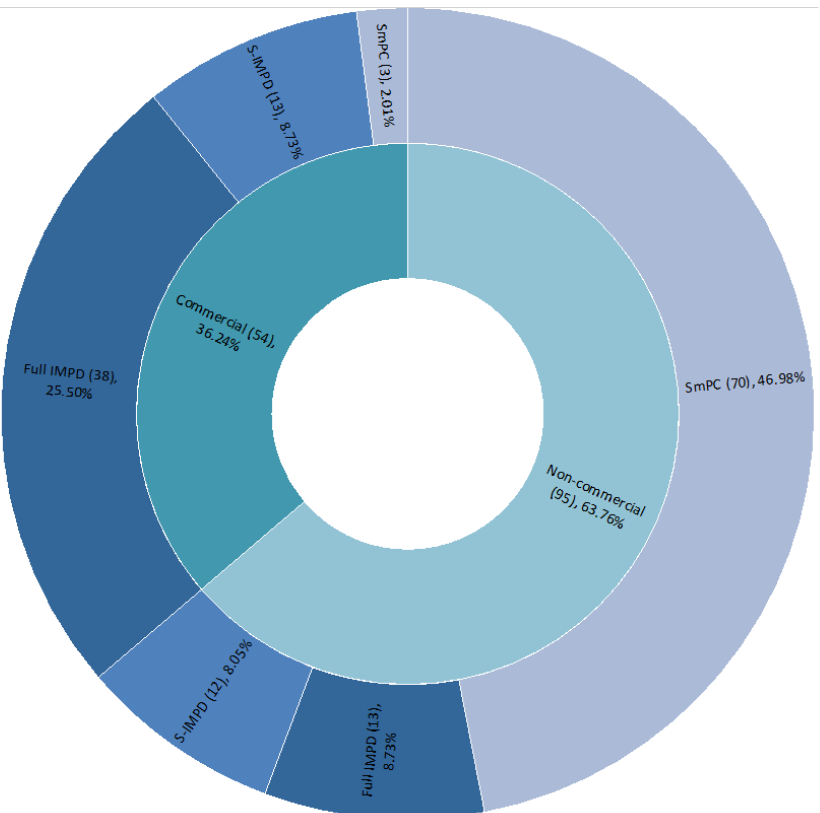
Figure 4. Percentage (number) of quality documentation types for commercial and non-commercial COVID-19 CTs assessed from March 2020 to March 2021.